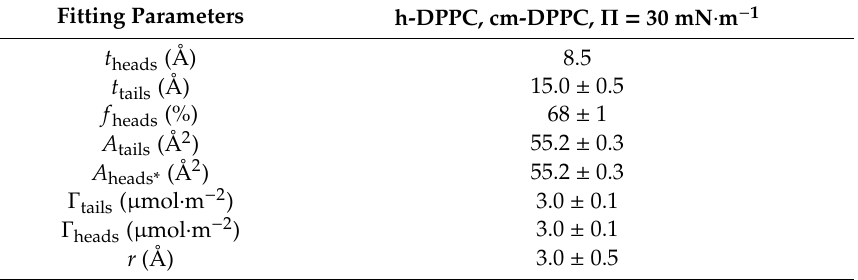
Table 2. Parameters resulting from the data modeling. * The hydration degree of the headgroups are considered